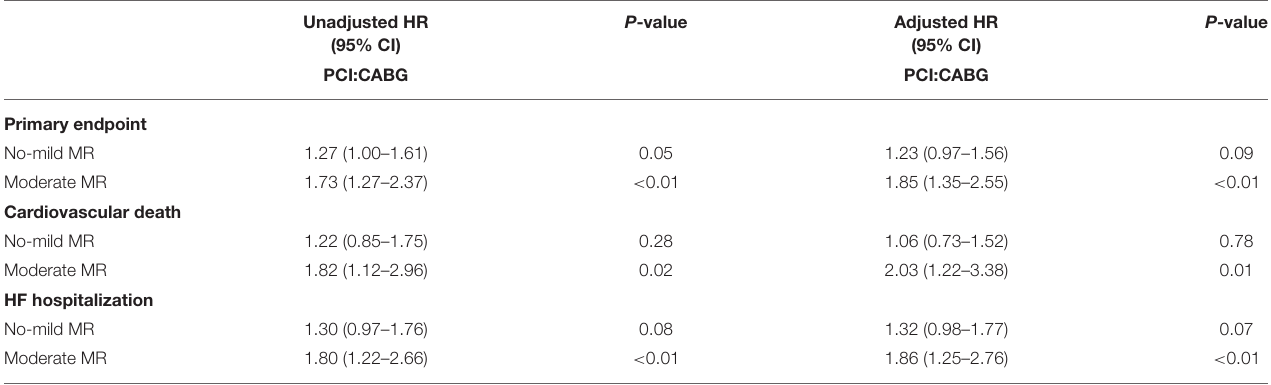
TABLE 3 | Risk of the primary and secondary endpoints in patients stratified by the severity of MR. Unadjusted HR (95% CI)